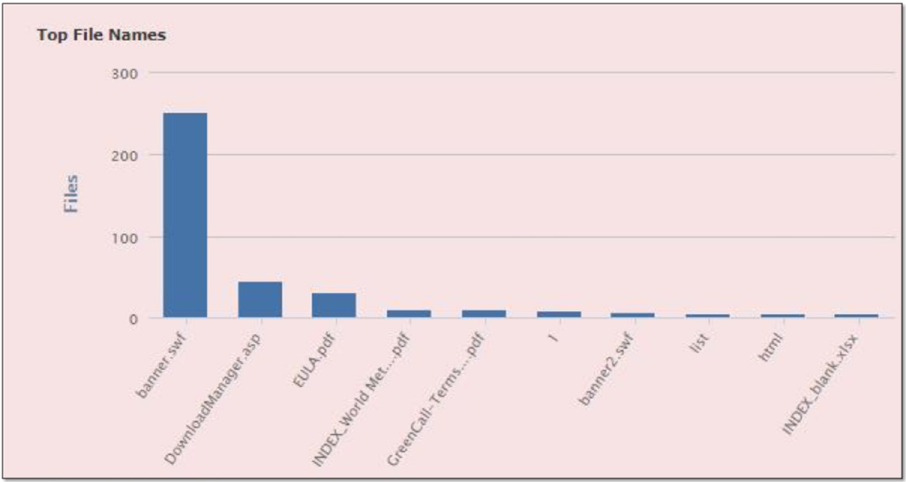
Figure 8. Top File Names extracted from Firepower.